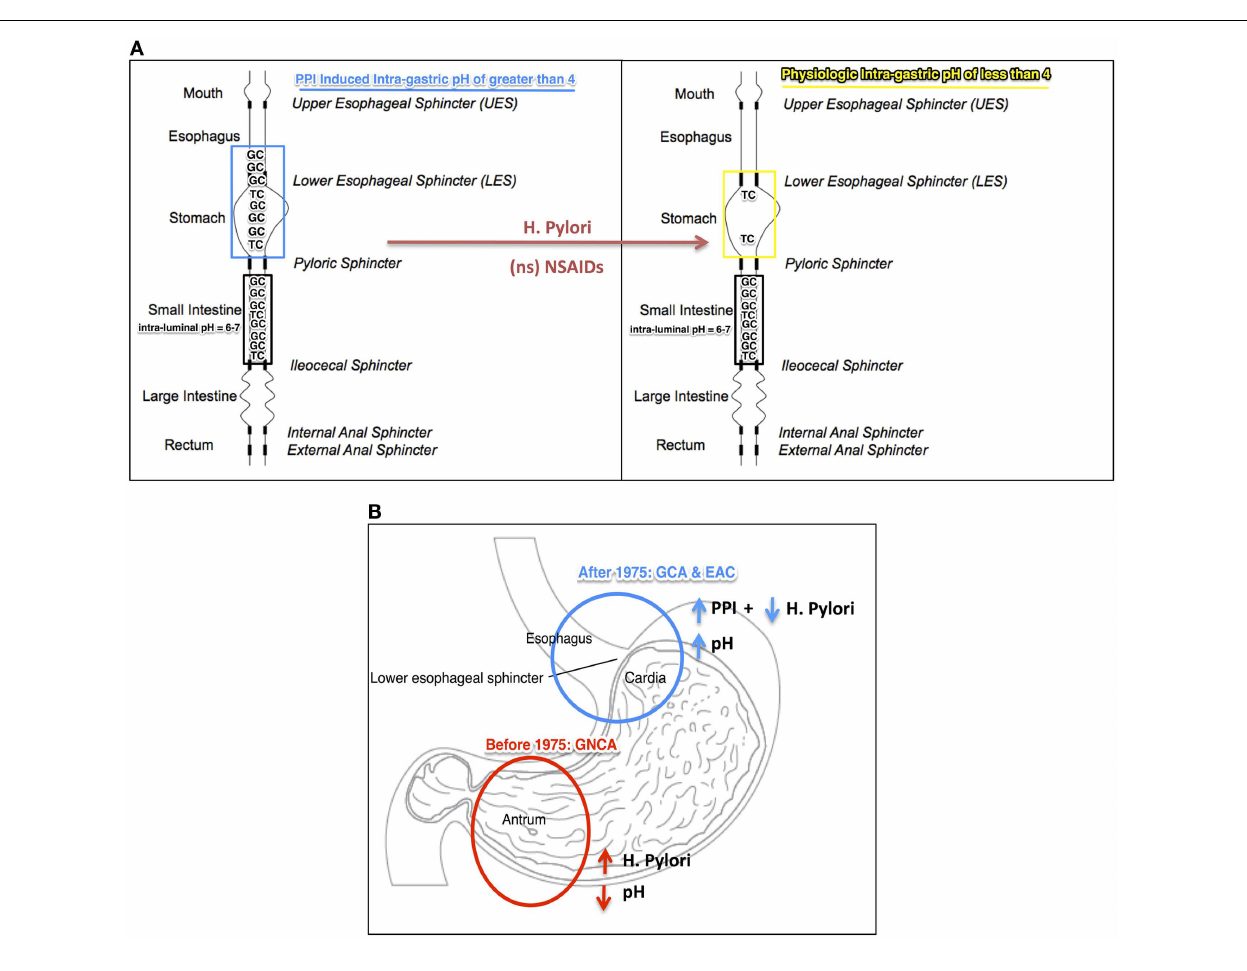
increase acid secretion and shift the intra-gastric pH to lower than 4 (“safe-zone”), thereby preventing bile salt ionization. (B) Anatomical representation of the location of malignancy with high incidence rate in the United States, before and after 1975: non-cardia adenocarcinoma (GNCA), in red, before 1975 when H. pylori infection was high and PPI not in chronic use; gastric cardia adenocarcinoma (GCA) and esophageal adenocarcinoma (EAC), in blue, after 1975, with reduced incidence of H. pylori and the advent of long-term use of PPI.TG, tauroconjugate; GC,